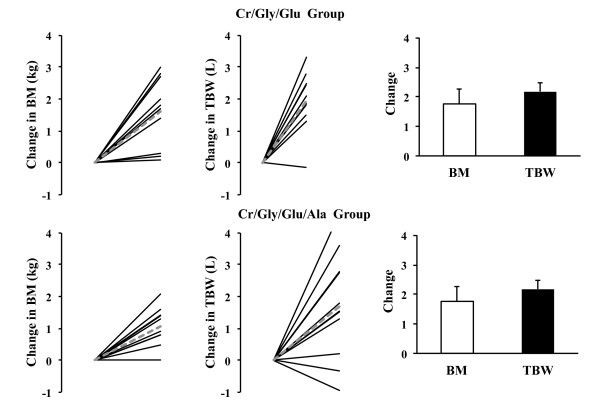
Changes in Body Mass (BM) and Total Body Water (TBW) induced by supplementation in Cr/Gly/Glu (top) and Cr/Gly/Glu/Ala (bottom) groups. Dashed lines represent mean of the group and solid black lines represent individual data (data presented for both ‘responders’ and ‘non-responders’). Bar charts represent Mean ± SD values of change in TBW and BM for responders only. *Significant (P < 0.05) difference between post and pre supplementation.